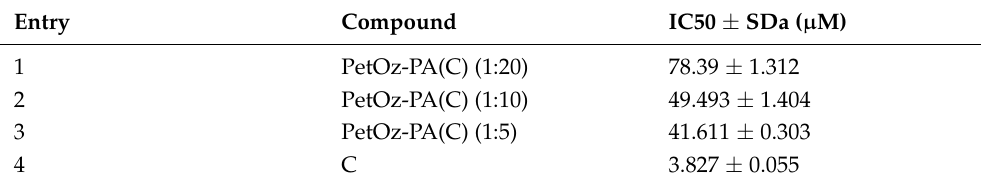
Table 3. PetOz-PA(C) free radical-scavenging activities measured using the DPPH assay ( n =